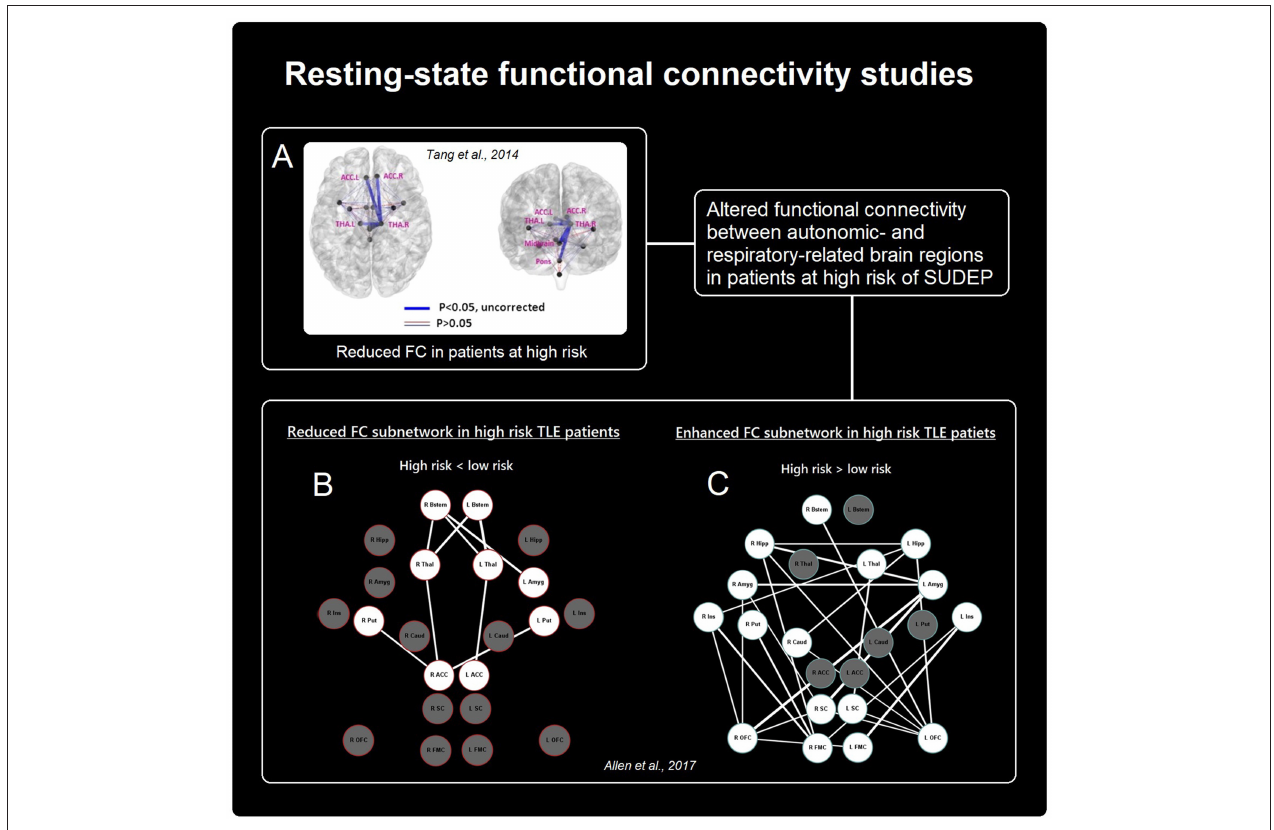
FIGURE 2 | Summary of rs-FC findings in patients at risk of SUDEP. Altered connectivity between cortical and sub-cortical autonomic- and breathing-related sites. (A,B) Show reduced functional connectivity in patients at high risk [Adapted from ( 51), A and (52), B ], while (C) Shows increased connectivity between primarily frontal and limbic sites in those at high-risk [Adapted from (